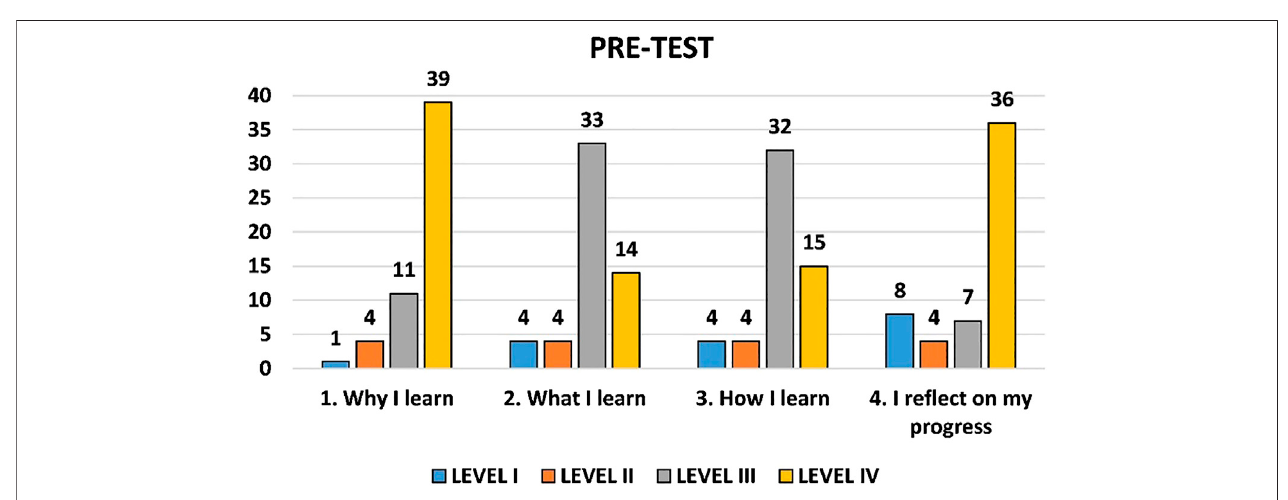
FIGURE 6 | Acquiring learning to learn competence (pretest) by dimension and level of progression ( N (cid:1) 55).